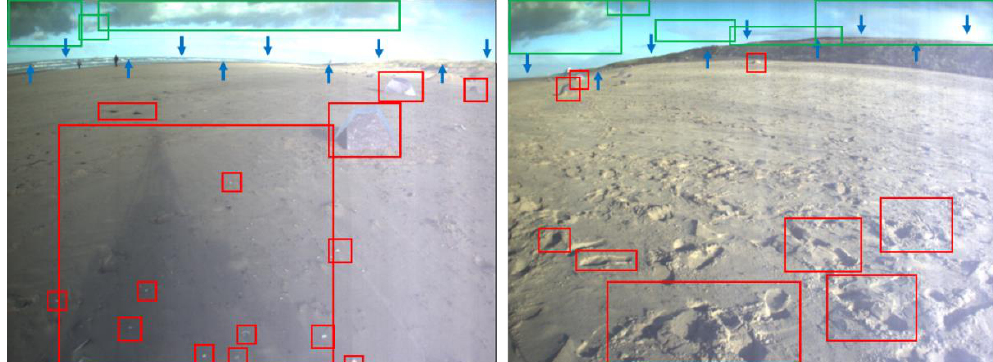
Figure A6. The example landmarks in the navigation visions of the planetary rover (the Katwijk planetary rover dataset). The green frames, red frames, and blue arrows refer to landmarks in sky, ground, and horizon, respectively. For example, shadows, rocks, stones, traces, clouds, hills, mountains, and etc.